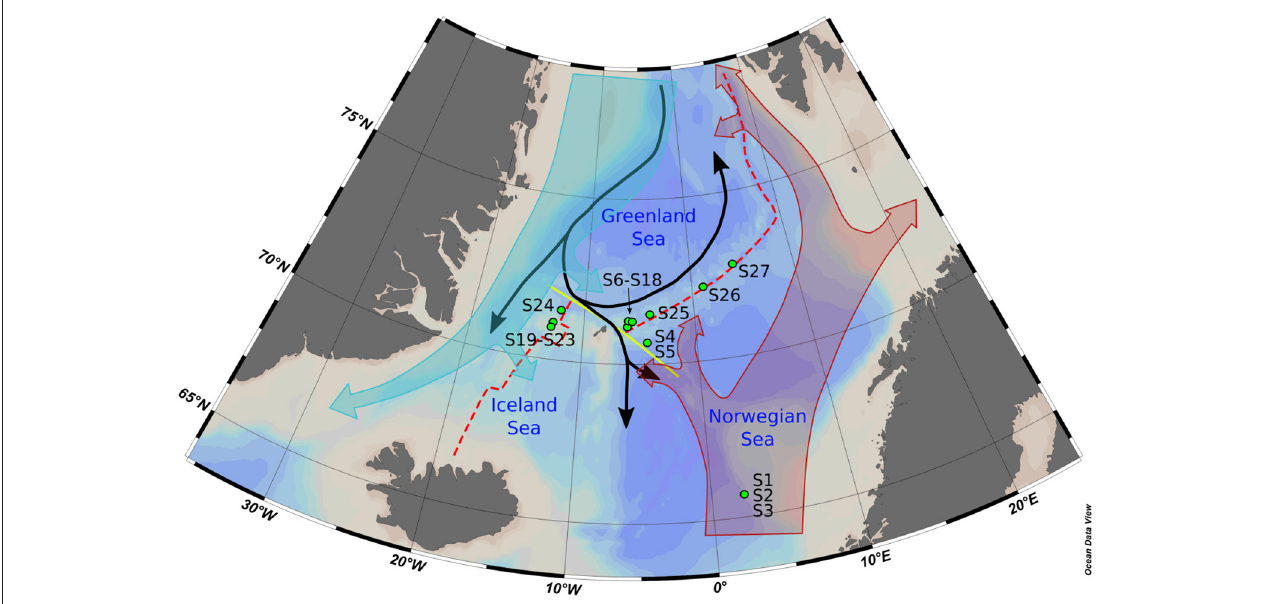
FIGURE 1 | Map of the bathymetry of the Nordic Seas with the main features mentioned in the text. The water circulation depicted has been simplified to provide only the informations relevant to the study. Samples S6–S18 have been taken in the vicinity of the Jan Mayen vent Field, while samples S19–S23 were taken at the Seven Sisters Vent Field. Red dashed line, Arctic Mid-Ocean Ridge; yellow line, Jan Mayen Fracture Zone; black arrow, Norwegian Sea deep water currents; filled turquoise arrow, surface East Greenland Current; filled red arrow, surface Atlantic Water; green points, CTD